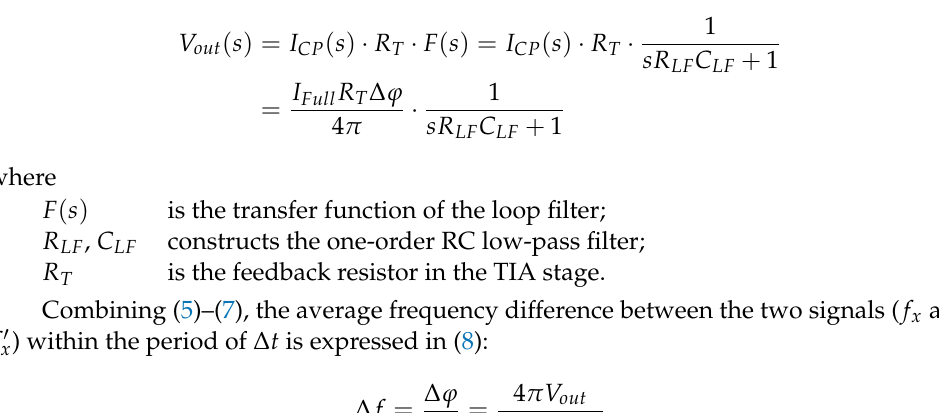
Figure 6. Schematic diagram of the current-to-voltage transformation. The relationship between the input current ( I CP ) and the output voltage ( V out ) in the S-domain can be expressed in